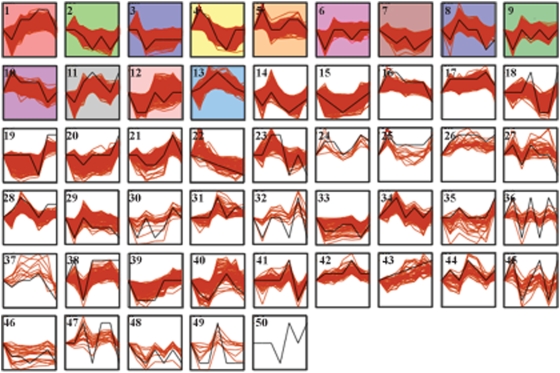
Thirteen significant expression profiles are found in the N2 data.The N2 expression data was loaded into STEM, which used 50 model profiles to cluster the data. The profiles are in order of statistical enrichment for genes matching the model profile. The model profile is in black while the gene expression patterns for each gene within the cluster are in red. The colored profiles are statistically significant, with p-values ranging from greater than 1e-226 to 7e-10. The number of genes assigned to each significant cluster ranges from 2,037 to 303. 9,593 genes were placed into a significant cluster. Clusters with similar colors show similar patterns. All expression profiles have a zero time point added to them so as not to force the egg stage to be the zero time point. The clusters were numbered prior to placing genes into clusters, and thus the numbers of the clusters are not correlated with significance.